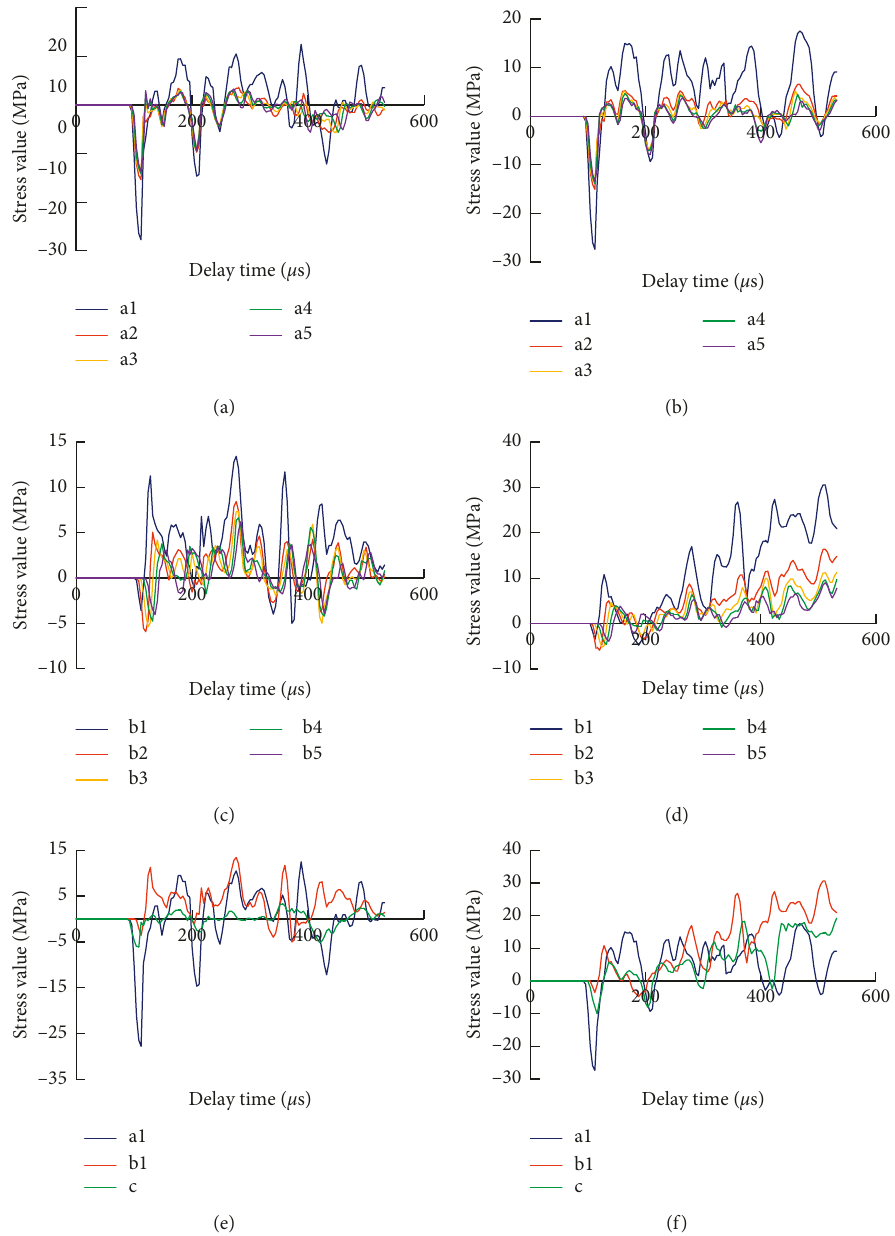
Figure 12: Stress concentration curve of elements of the TBH wall before TBH initiation when the delay time is 536 μ s. (a, c, e) The PBH is a round hole. (b, d, f) The PBH is a notch